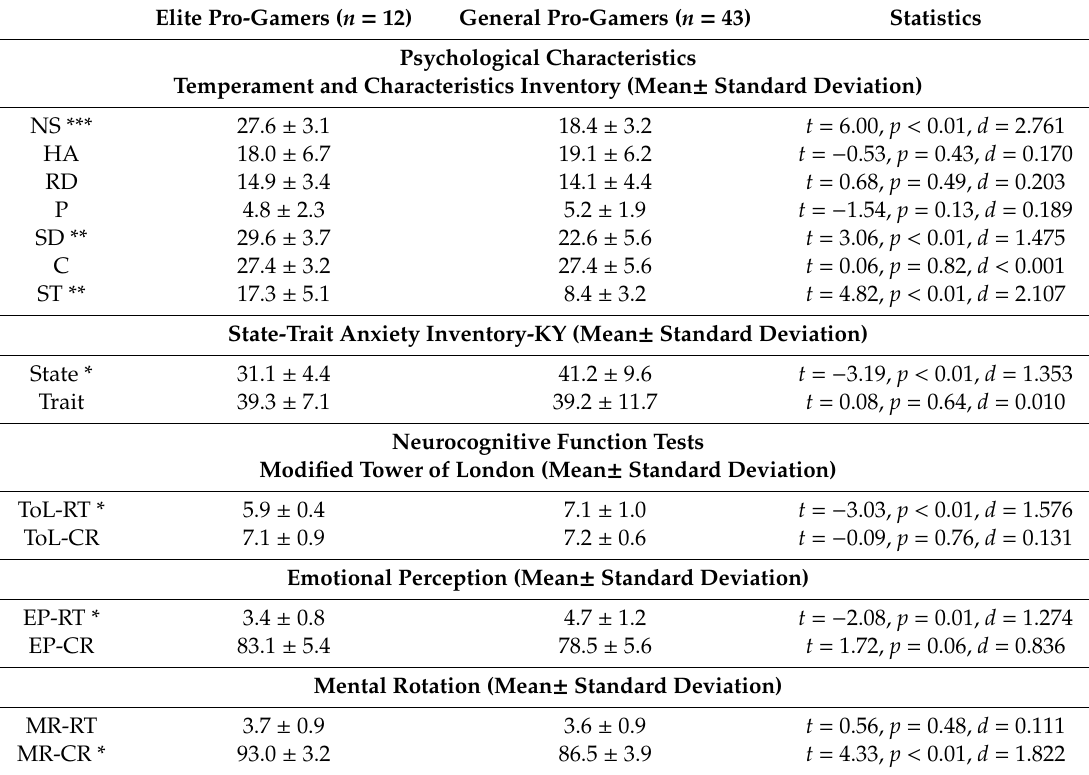
Table 3. Comparison of psychological and cognitive characteristics between elite pro-gamers and general pro-gamers.